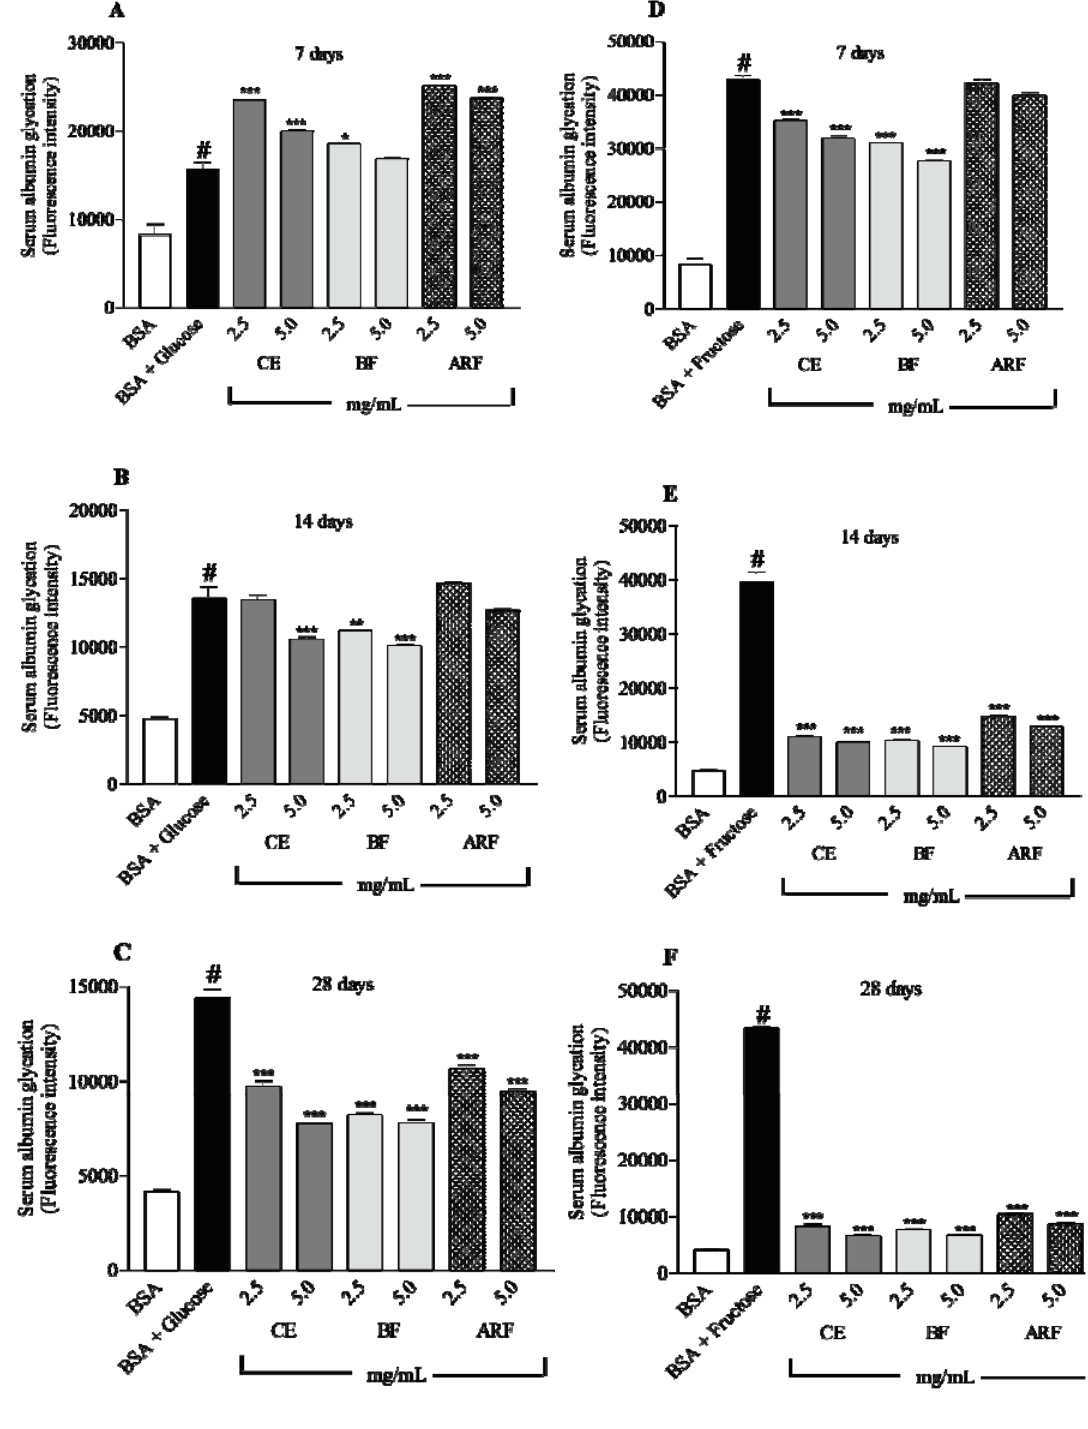
Figure 3. Inhibitory effect of crude extract (CE), n -butanol fraction (BF) and aqueous residual fraction (ARF) of B. articulata on the formation of fluorescent AGEs in a BSA/glucose or BSA/fructose system. ( A, B and C ) 7, 14 and 28 days BSA/glucose; ( D, E and F ) 7, 14 and 28 days BSA/fructose. Values are expressed as mean  S.E.M; n = 6 in duplicate for each group. Significantly different to the corresponding control group (BSA/glucose or BSA/fructose); * p < 0.05; ** p < 0.001; *** p <